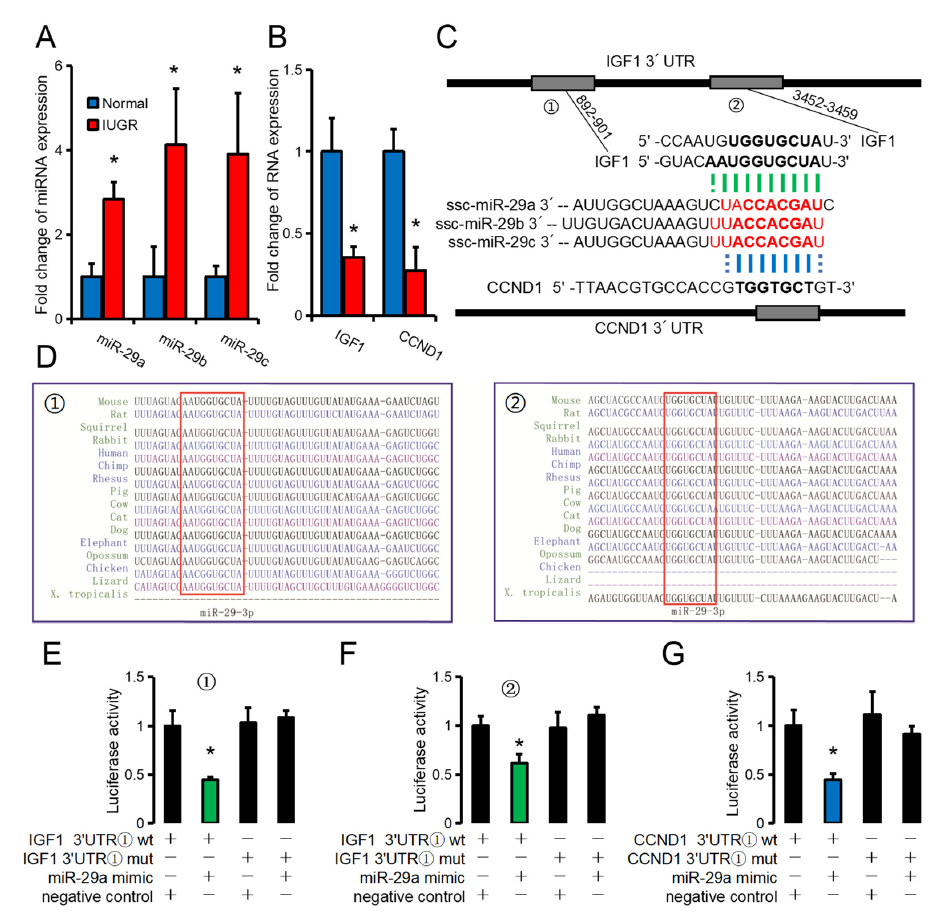
Figure 6. IGF1 and CCND1 as common target genes of miR-29a. ( A ) Relative expression of the miR-29 family in skeletal muscle of neonatal piglets; ( B ) Relative expression of IGF1 and CCND1 in skeletal muscle of neonatal piglets; ( C ) Potential binding sites of the miR-29 family to the 3’UTR of IGF1 and CCND1; ( D ) TargetScan results showed the conservation of potential binding sites of the miR-29 family to the 3’ UTR of IGF; ( E , F ) The dual-luciferase reporter system showed the binding relationship of miR-29a to the ① ( E ) and ② ( F ) of the 3’UTR of IGF1 and to the 3’UTR of CCND1 ( G ). N = 3. * p -value < 0.05.